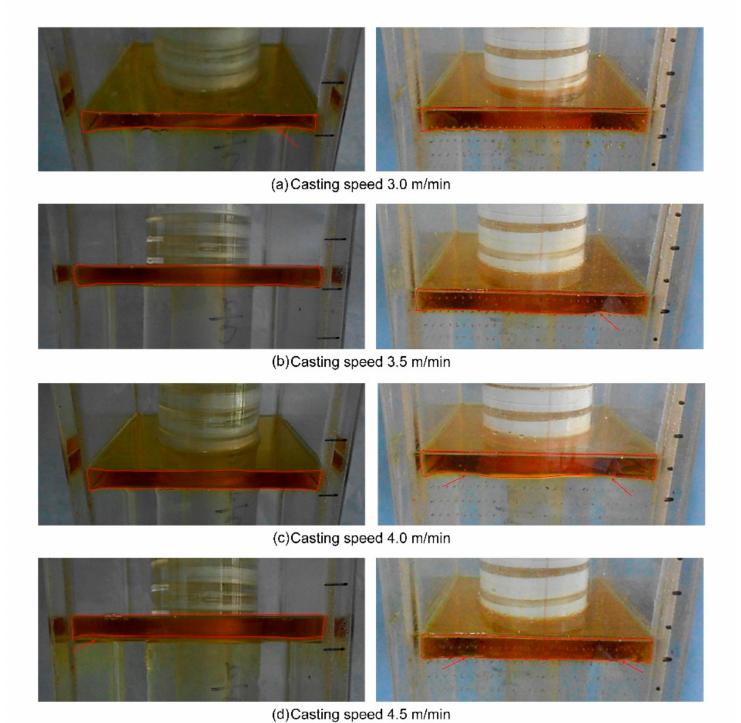
Figure 10. Distribution of liquid slag in the mold of two sorts of hydraulic modeling experiments at various casting speeds without a solidified shell (left), and with a solidified shell and hydrostatic pressure (right). ( a ) 3.0 m / min; ( b ) 3.5 m / min; ( c ) 4.0 m / min; ( d ) 4.5 m /